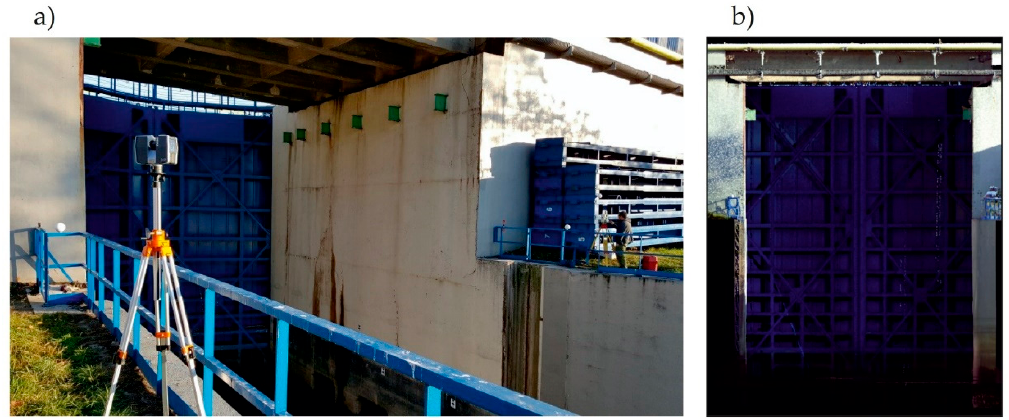
Figure 8. Laser scanner operation. ( a ) General view; ( b ) Scanning result, namely, a cloud of points, along with red-green-blue (RGB) color code.